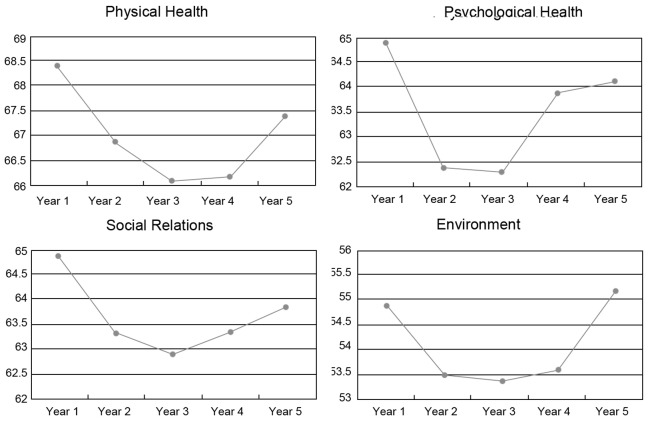
Scores of each domain for nursing.